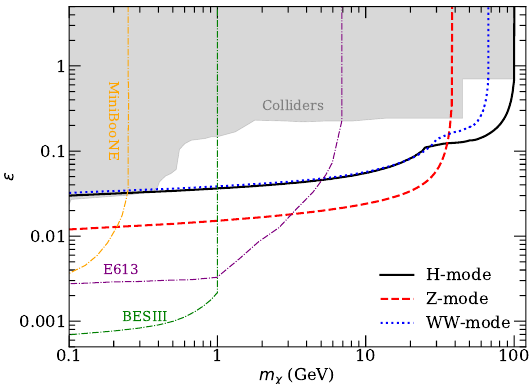
Figure 10 . Expected 95% CL upper bounds on millicharge with 5.6 ab (cid:0) 1 data in the H -mode (black-solid), with 16 ab (cid:0) 1 data in the WW -mode (blue-dotted), and with 2.6 ab (cid:0) 1 data in the Z -mode (red-dashed). Previous collider bounds are shown as the gray shaded region [32]; expected sensitivity studied in previous analyses are also shown for comparison, including E613 [33], Mini- BooNE [34], and BESIII